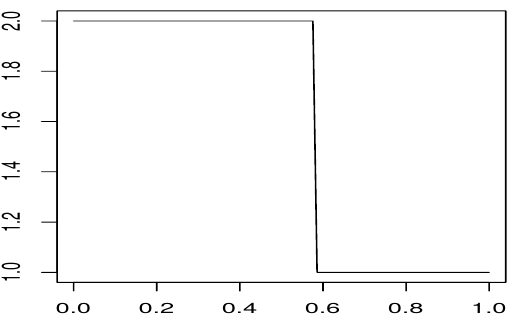
Figure 4. Optimal action for the state 3 depending on believe